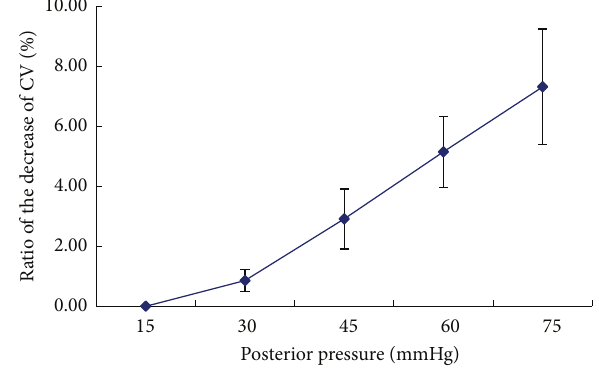
Figure 2: The change of rabbit corneal volume (CV) with the increase of posterior pressure. The ratios of the decrease of CV − CV )/ CV were calculated as ( CV 15 15 mmHg . The mmHg posterior pressure ratios were shown linearly with the increase of posterior pressure ( 𝑅 2 = 0.98